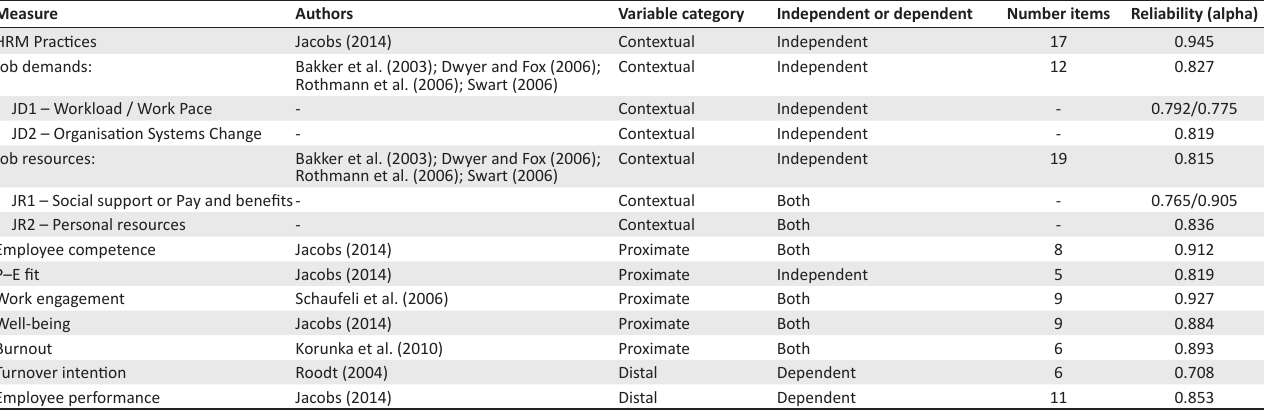
TABLE 2: A summary of the measures and their use in the study. Measure